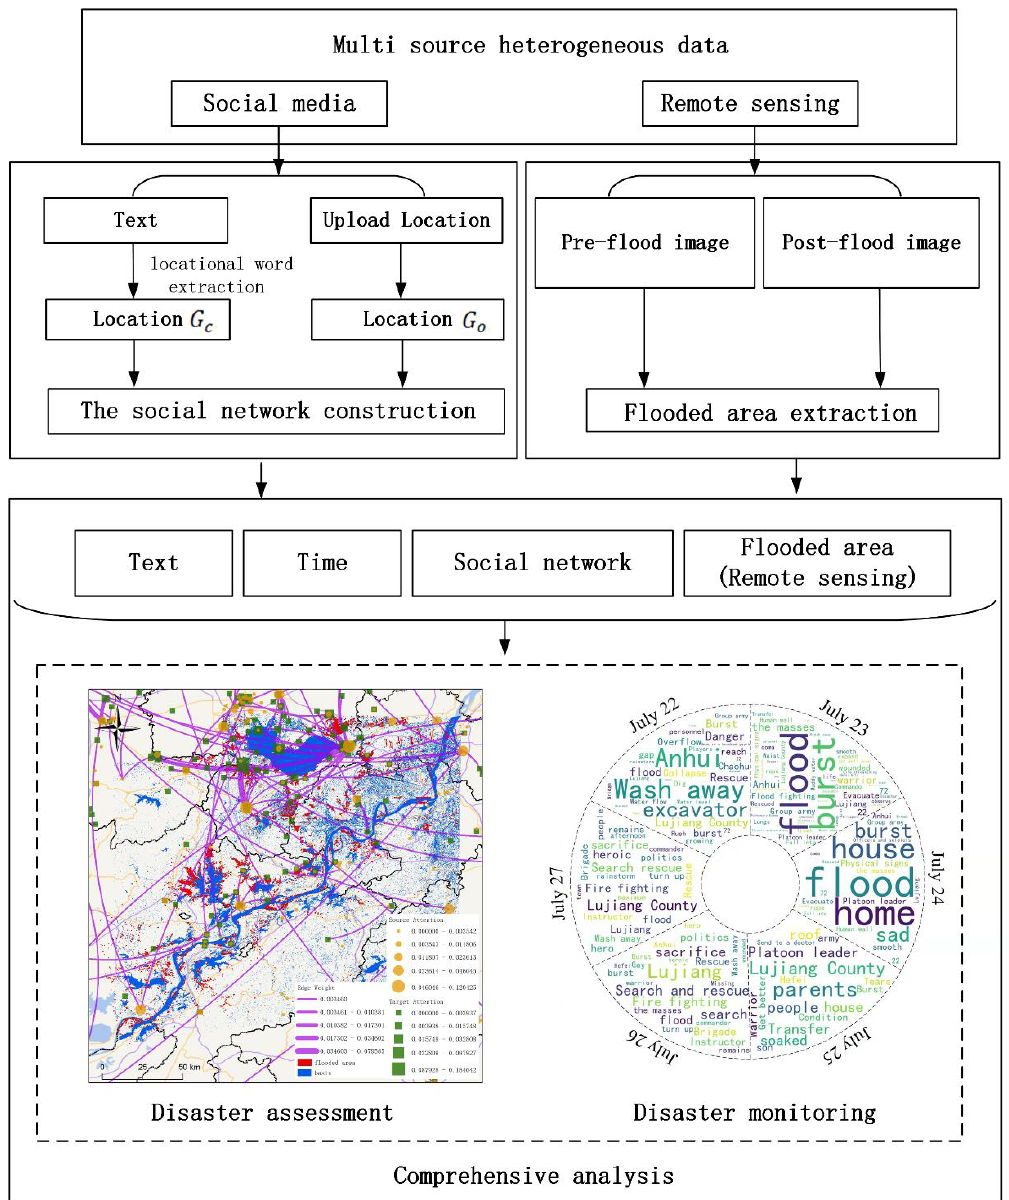
Figure 2. The structure of the proposed framework in this paper.